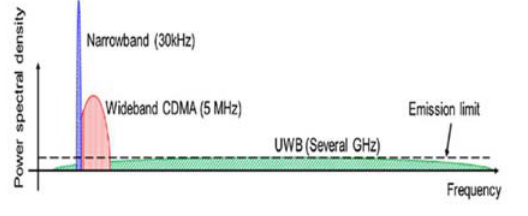
Fig. 1. Power spectral density versus frequency of the Narrowband, the Wideband, and the UWB [1]. The fractal structures have gained a lot of interest in the realization of UWB sensing antennas in miniaturized space. This type of antenna is known for its ability to create multiple resonant frequencies with their repetitive topology and ease installation in RF circuits. Various ultra-wideband antennas based on fractal geometry were introduced in the literature. The authors in [11]